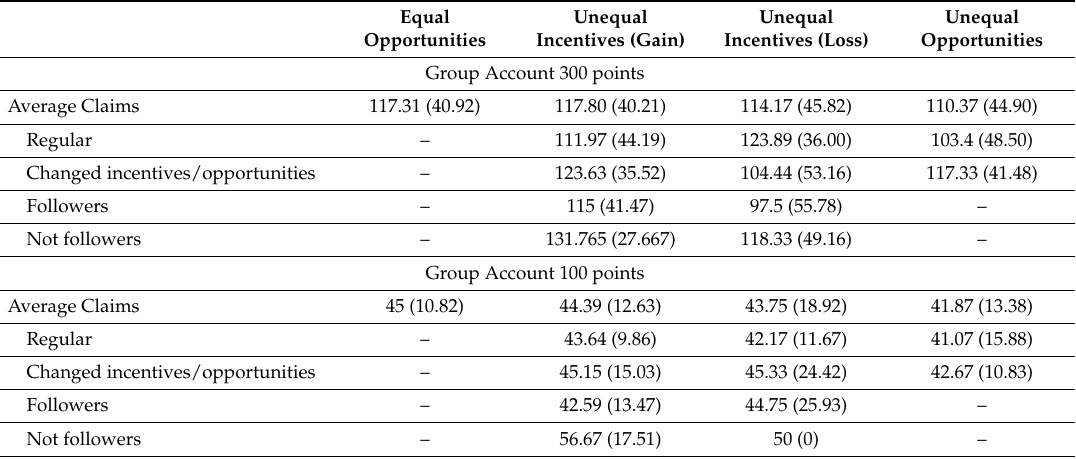
Table A2. Minimum demands in case of equal